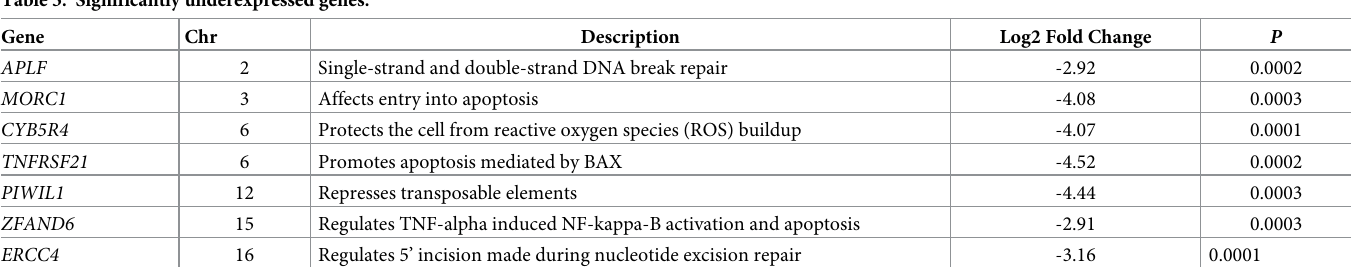
Table 5. Significantly underexpressed